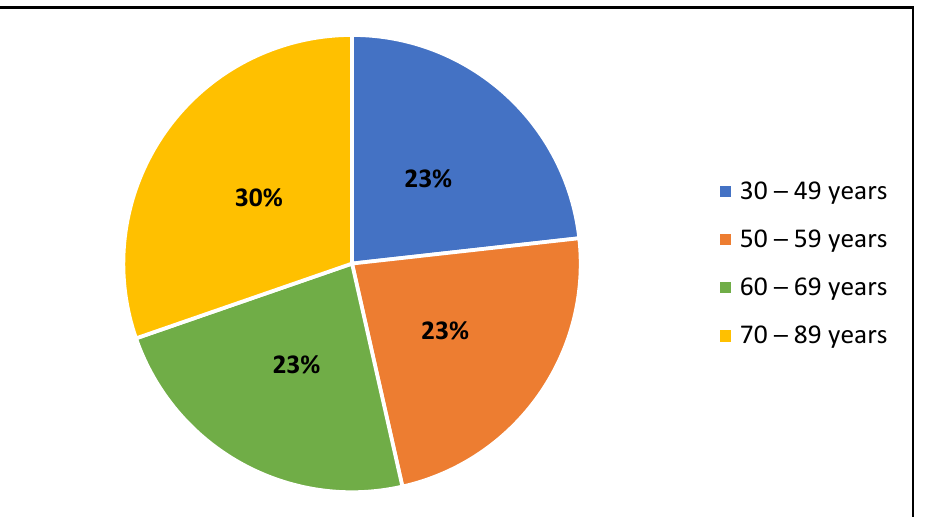
Figure 3. Age distribution of the community cohort study. Table 1. Repeated measurement of patients at a moderate risk of